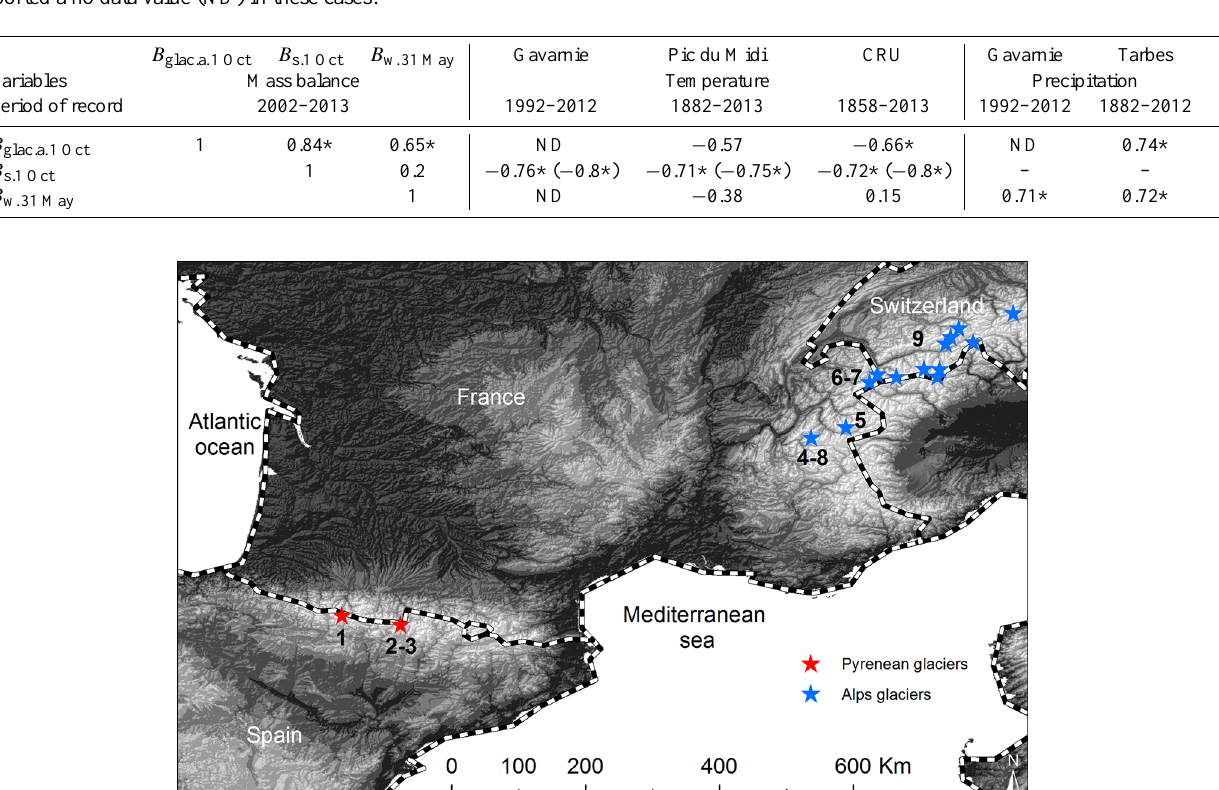
Table 5. Correlation matrix (Spearman’s ρ s ) between the meteorological time series and Ossoue Glacier mass balances components after removal of linear trends (calculated in a fixed date system, Cogley et al., 2011). Correlation values given in parentheses are based on the monthly mean values. Significant correlations ( p values < 0.05) are marked with asterisks. The Gavarnie time series was not complete enough to perform the correlations between the annual mass balance and the annual mean temperature and precipitation over 2002–2011; we reported a no data value (ND) in these cases.